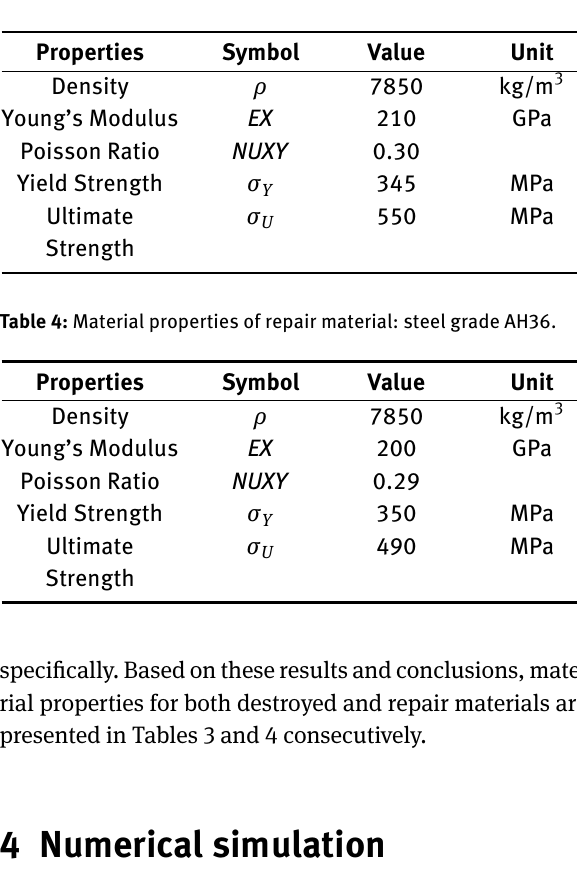
Table 3: Material properties of destroyed material: medium-carbon steel 1030.